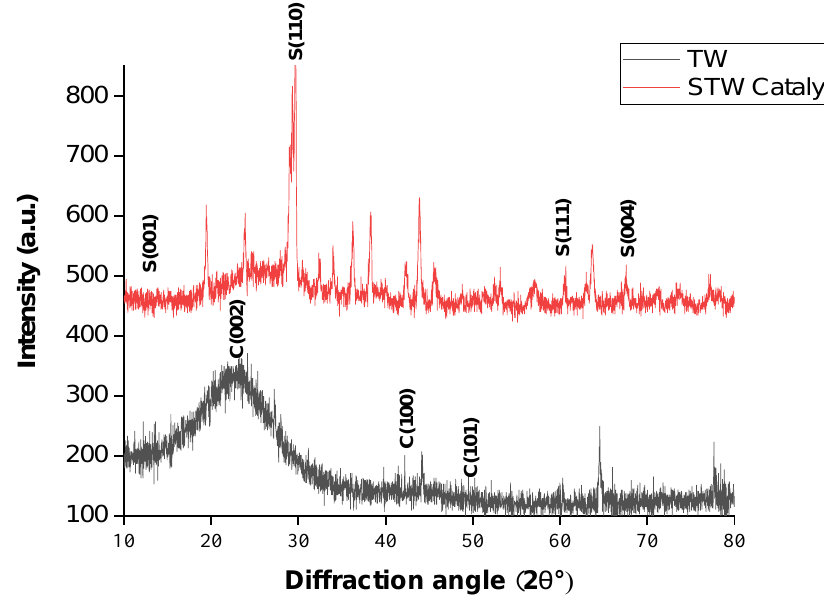
Figure 3. XRD diffractogram of sulfonated-derived tea waste; tea char (black) and sulfonated tea waste acidic catalyst (red).